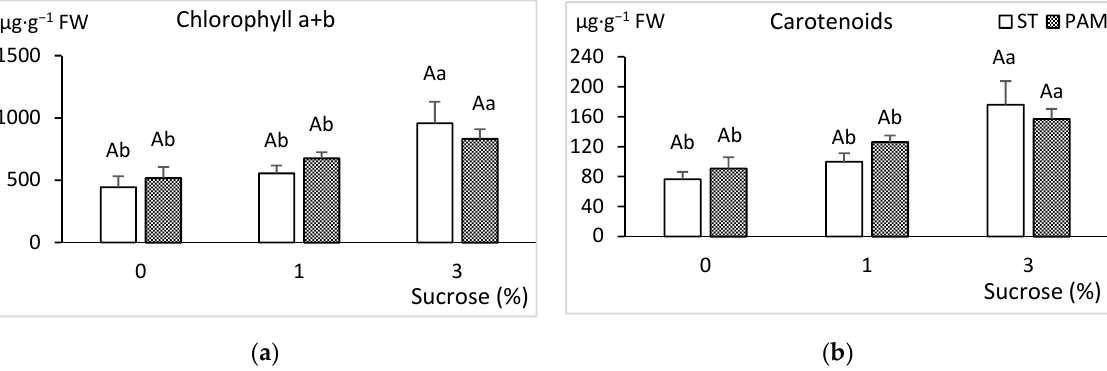
Figure 7. Effect of growth conditions and sucrose supplementation on the photosynthetic pigments of leaves of the genotype CBP cultured in RITA© with 6 immersions/day. ( a ) Chlorophyll a+ chlorophyll b and ( b ) total carotenoids. Different uppercase letters indicate significant differences in relation to the growth conditions, and different lowercase letters indicate significant differences in relation to the sucrose supplementation ( p < 0.05). ST: standard conditions, PAM: photoautotrophic conditions and FW: fresh weight.